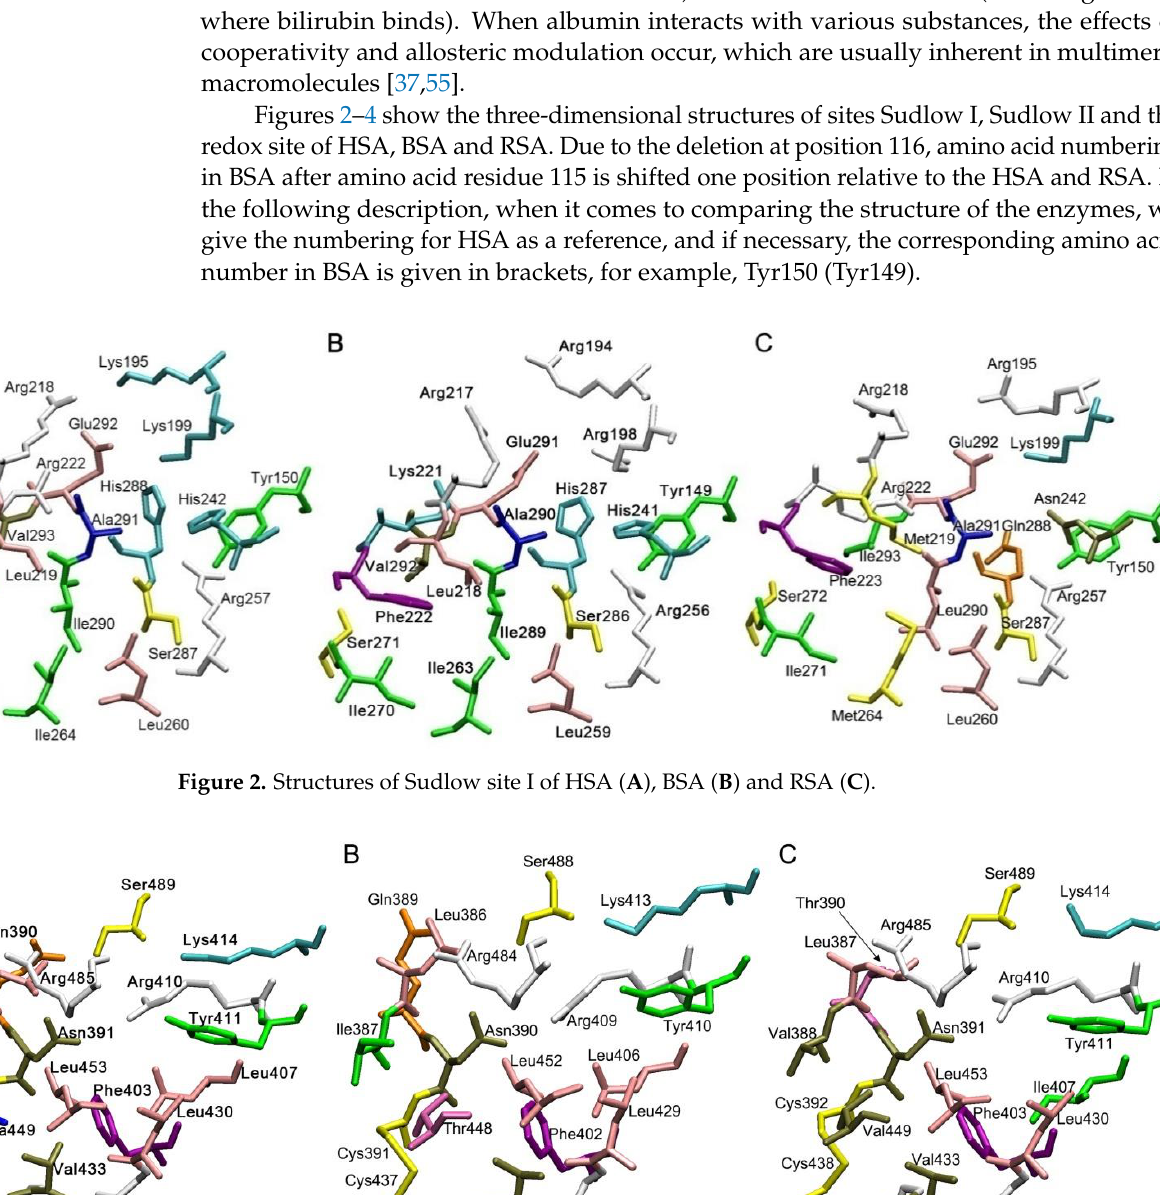
Figure 4. Structures of the redox sites of HSA ( A ), BSA ( B ) and RSA ( C